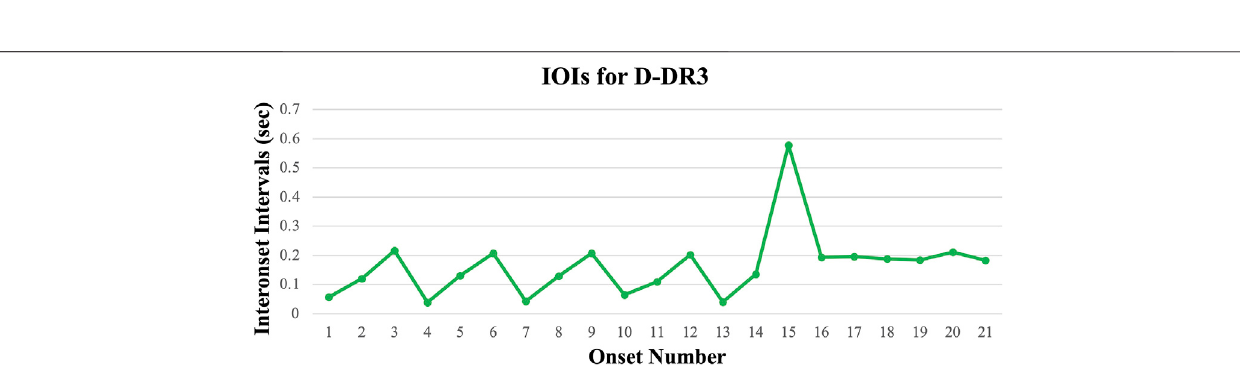
FIGURE5 | Interonset intervals (IOIs) for atypical drummingpattern inthe Drum Dance Rhythm condition (D-DR). The repeatingpatternofdurationspresentin the openingofthesampleroughlyfollowsa4:2:1ratio,whichtranslatesintodurationsof200,100,and50 ms,respectively,withmicrotimingvariationineachcategory.The sample ends with an isochronous series of durations (see sound Supplementary Samples 3